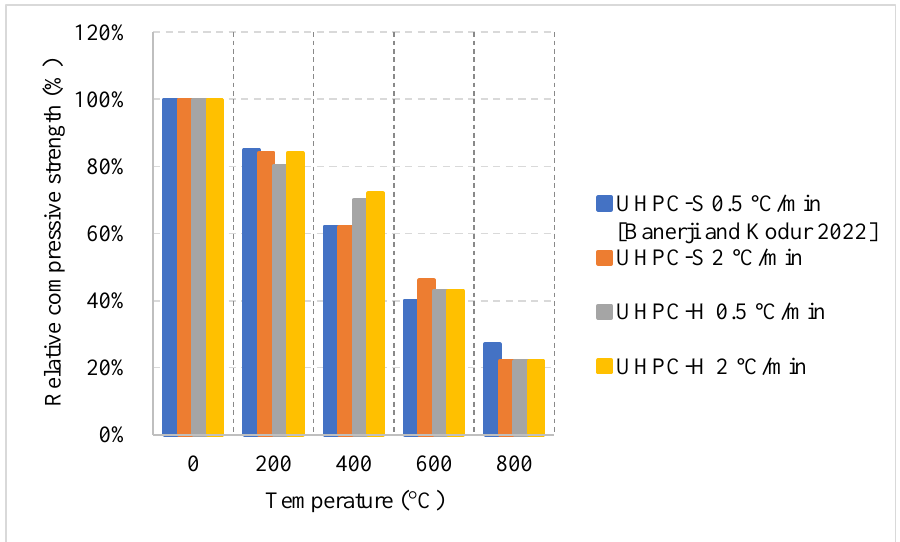
Figure 29. Relative compressive strength of UHPC under different heating rates. S: Steel Fiber, H: Hybrid between steel and Polypropylene Fibers [97].